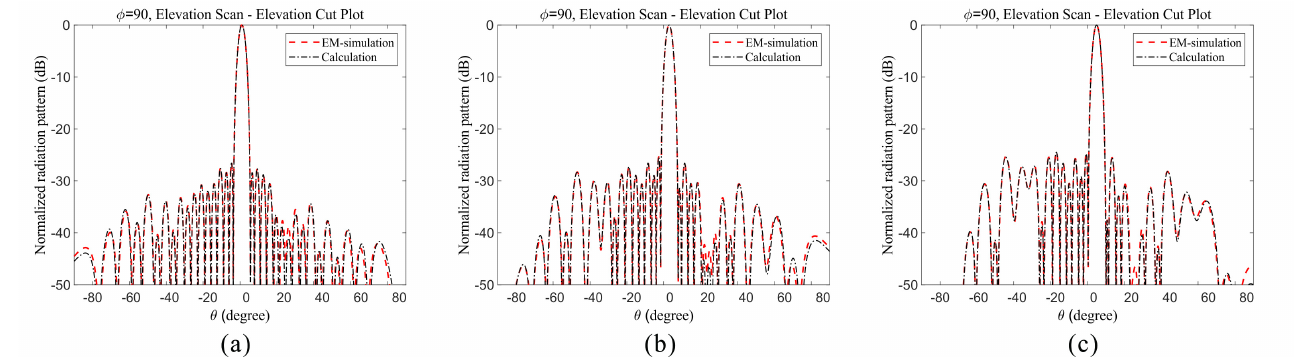
Figure 13. Radiation pattern with the scanning elevation at 30 GHz (calculation vs. EM full-wave simulation): ( a ) 1 ◦ scanning, ( b ) 3 ◦ scanning and ( c ) 5 ◦